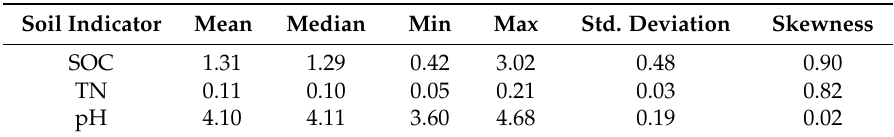
Table 1. Description of soil samples.